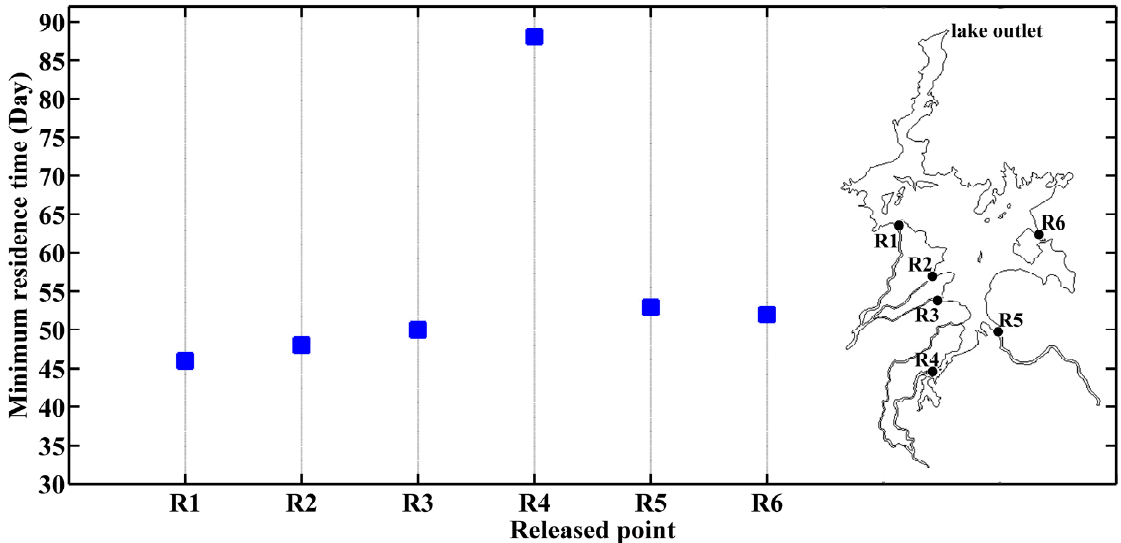
Figure 7. Distribution of residence times for the selected river mouths